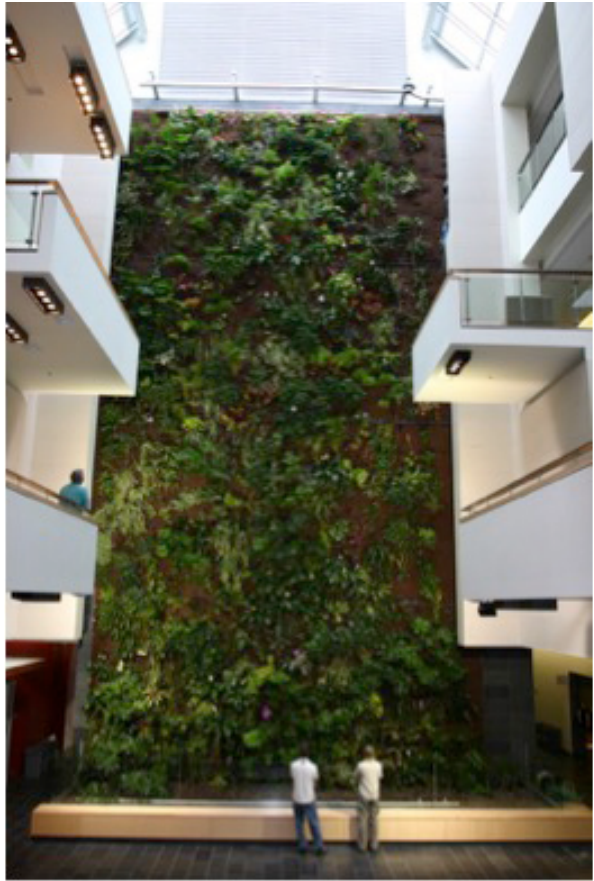
Figure 8: Guelph-Humber Living Wall, Humber College, Rexdale,